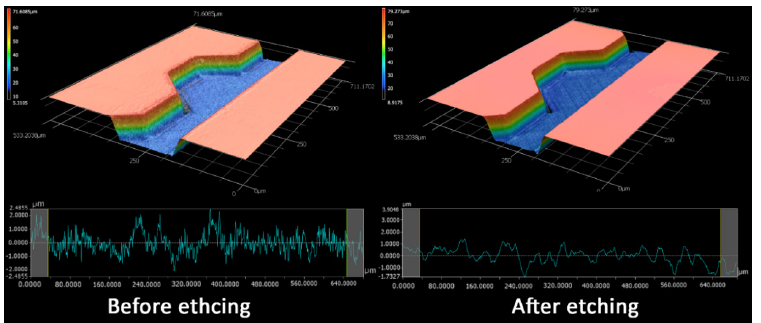
Figure 2. A 3D reconstruction of the fabricated channel showing the difference in surface roughness before and after the glass etching process. The arithmetic average values for the roughness profile ( R a ) are 0.6755 µm and 0.4571 µm before and after glass etching, respectively.